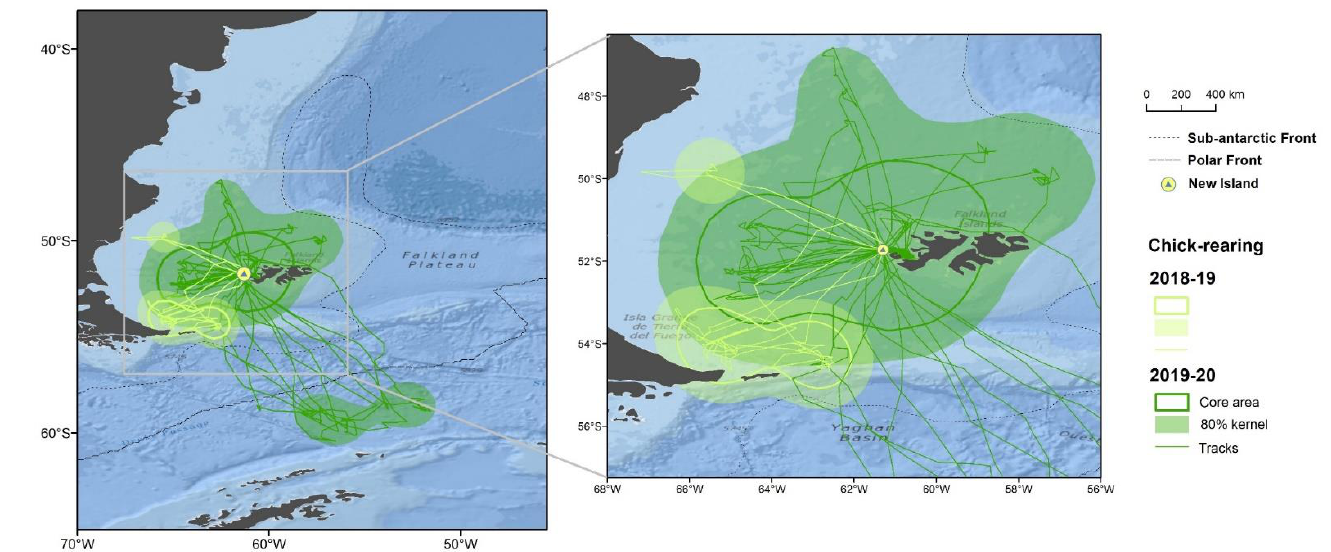
Figure 3. Tracks and main foraging areas (obtained by kernel analysis) of Thin-billed Prions from New Island during chick-rearing, recorded in two breeding seasons.